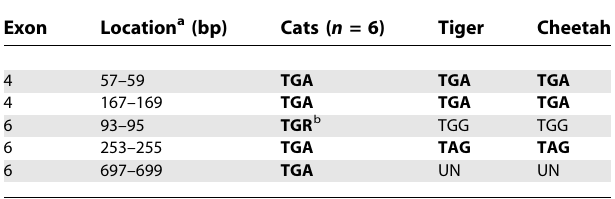
Table 2. Tas1r2 Stop Codons in Species of